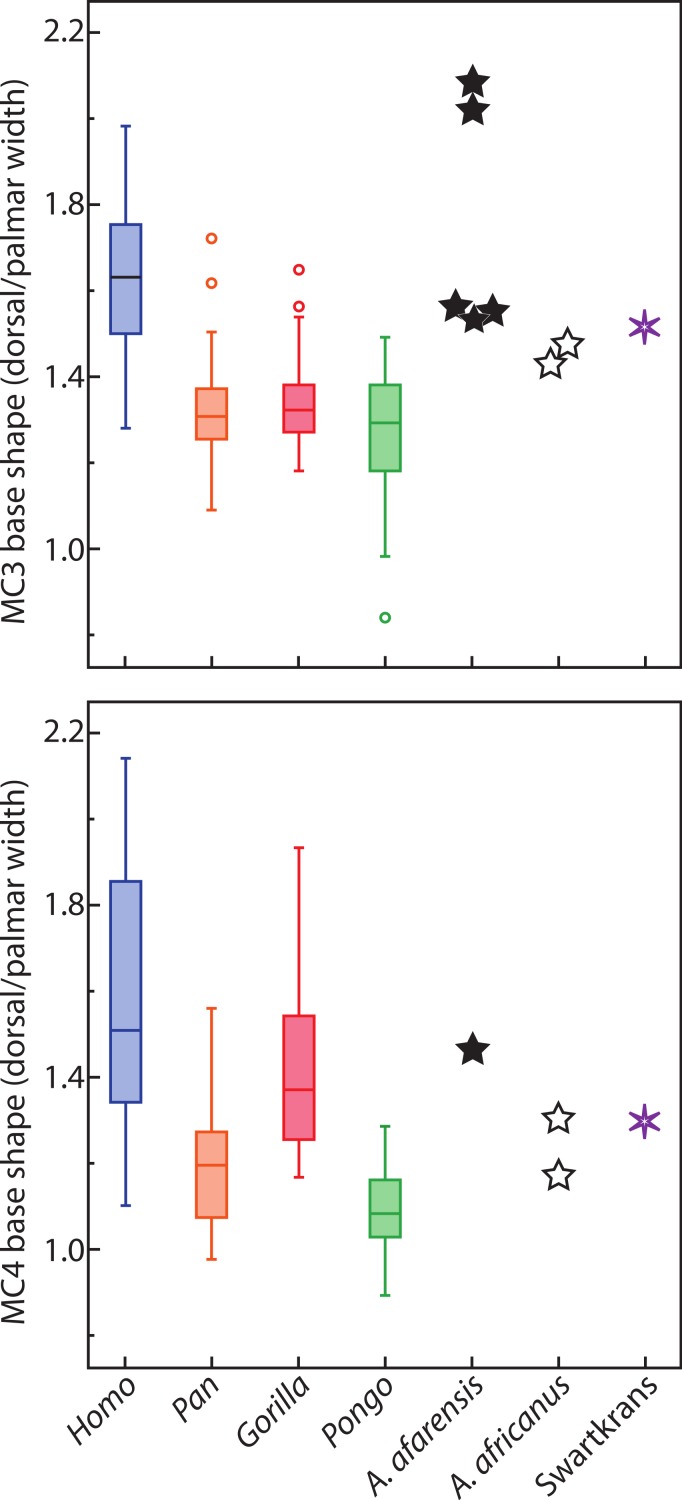
Metacarpal base wedging.Ratio of dorsal to palmar width of the base of MC3 and MC4. Higher ratios indicate a base that is more wedge-shaped, while a ratio of 1 indicates a base that is rectangular.